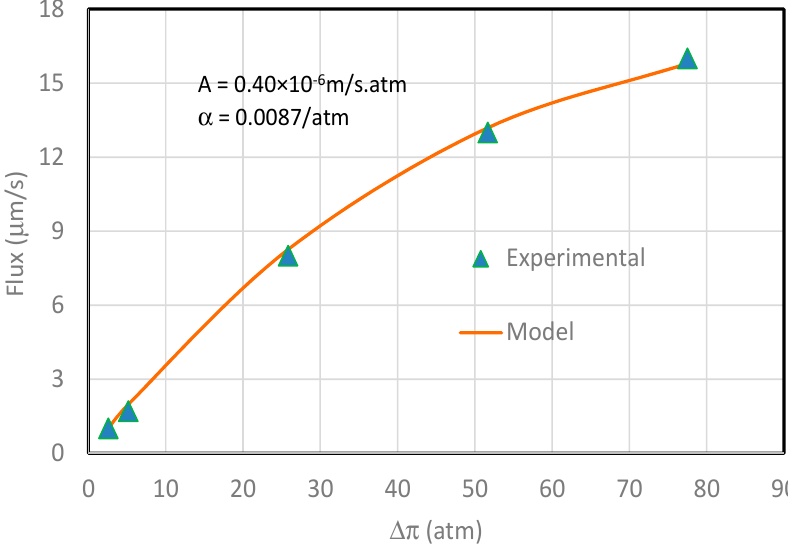
Figure 4. Modeled water flux (line) and experimental water flux (symbols) under osmotic pressure. The experimental data were taken from Figure 7 of Reference [30] and the parameters used in modeling are A = 0.40 µ m/s · atm, and α = 0.0087/atm.